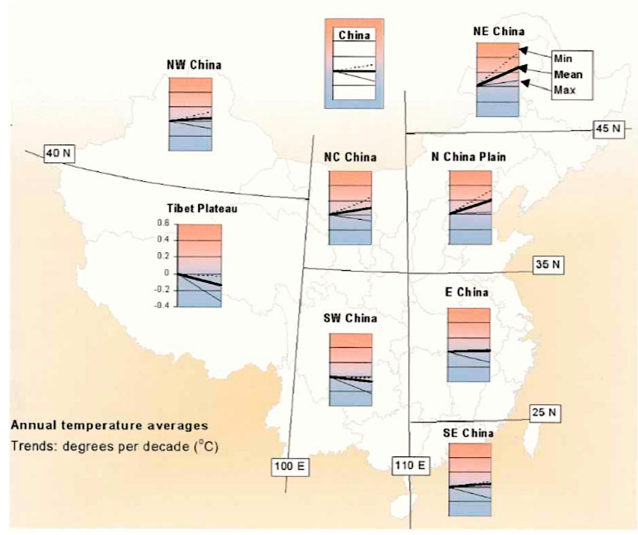
Figure 2. Annual temperature averages [28].